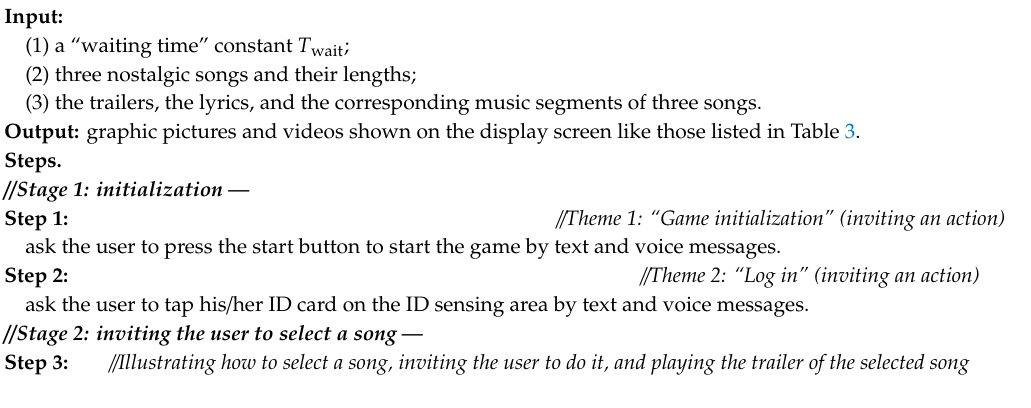
Algorithm 1. The “Guliu Guliu” game performed on the proposed interactive